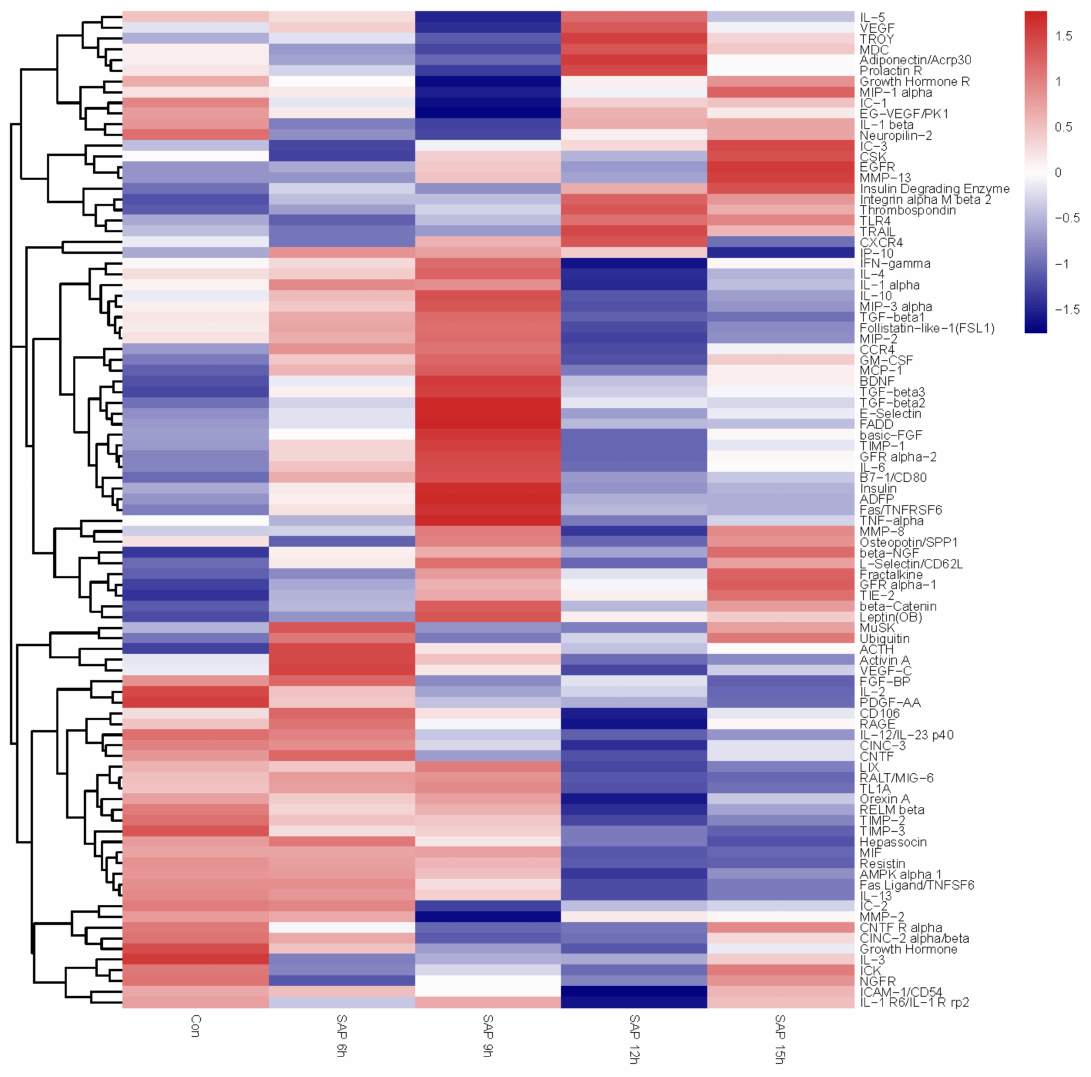
Figure 3. Hierarchical cluster analysis of the 90 cytokines, differentially expressed in rats of different groups. Firebrick: high expression; navy: low expression; white: moderate